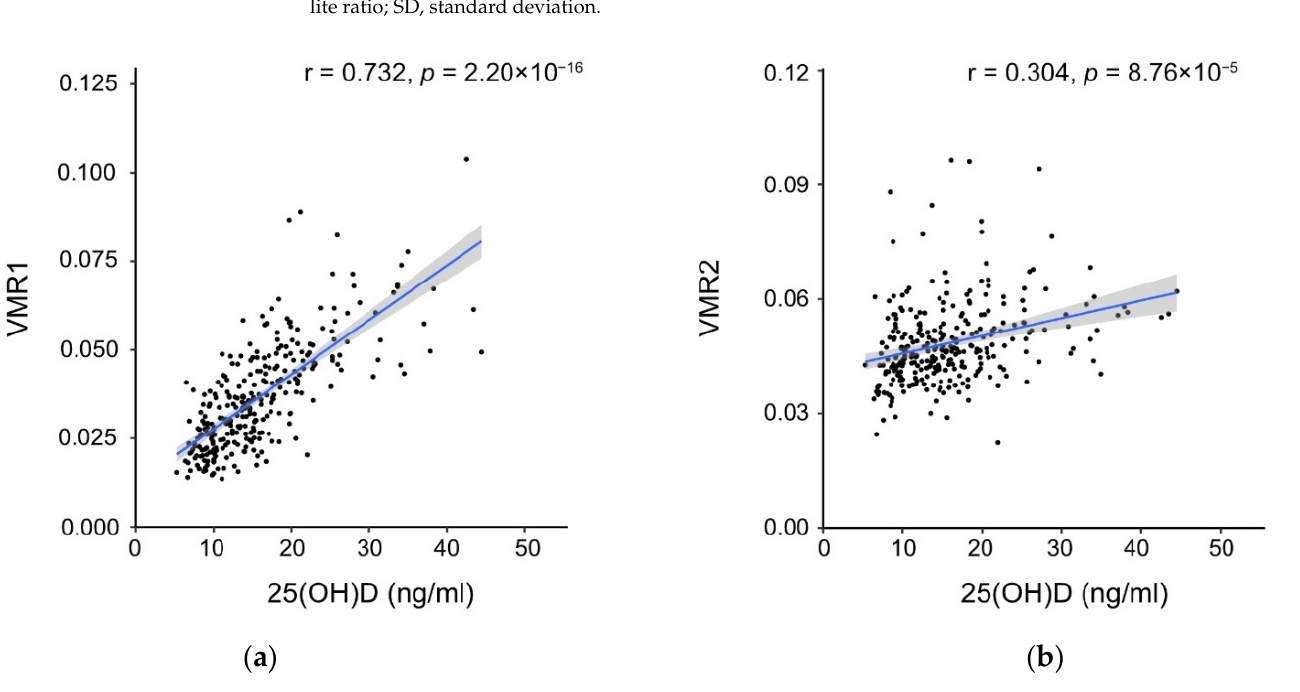
Figure 2. Scatter plots of VMR1 and 25(OH)D ( a ) and VMR2 and 25(OH)D ( b ). Scatter plots show that VMR1 has a strong correlation with 25(OH)D 3 (r = 0.732; p = 2.20 × 10 − 16 ), and VMR2 has a weak correlation with 25(OH)D (r = 0.304; p = 8.76 × 10 − 5 ). 25(OH)D, 25-hydroxyvitamin D; VMR, vitamin D metabolite ratio.